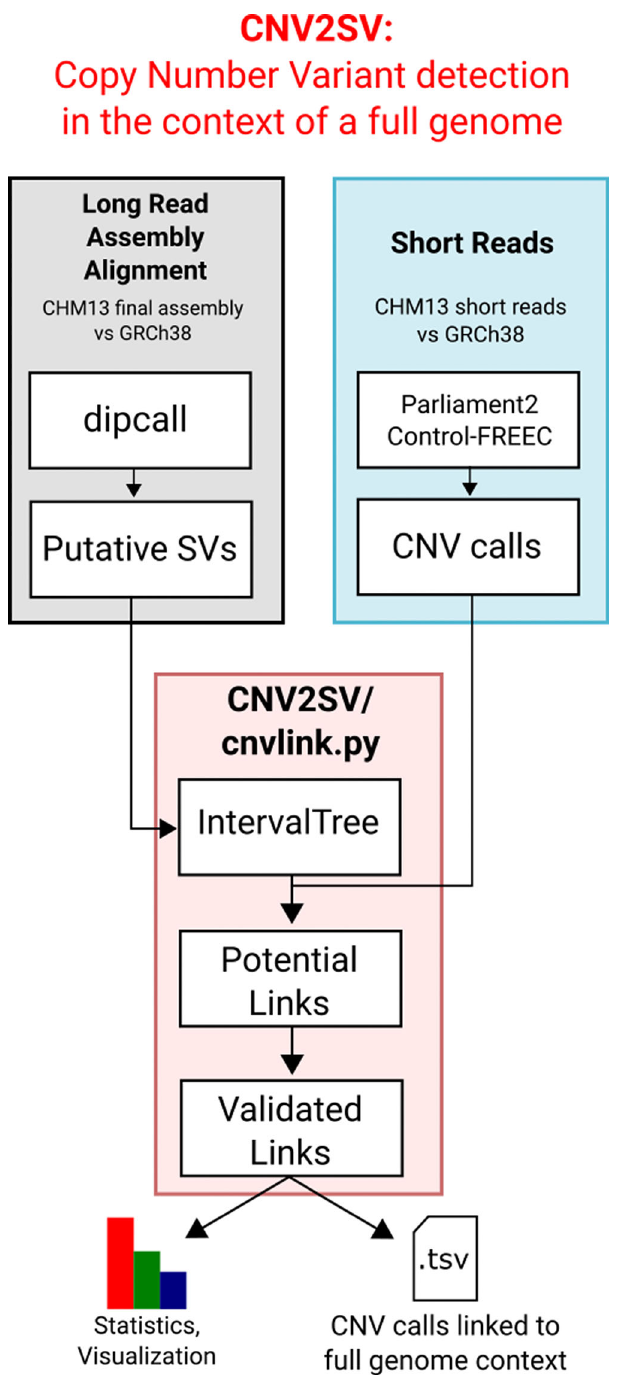
Figure 2. Agraphical overview of the CNV2SV pipeline. CNV2SV software pipeline that utilises both short and long read data as input to calculate the frequency of copy number variants across complete